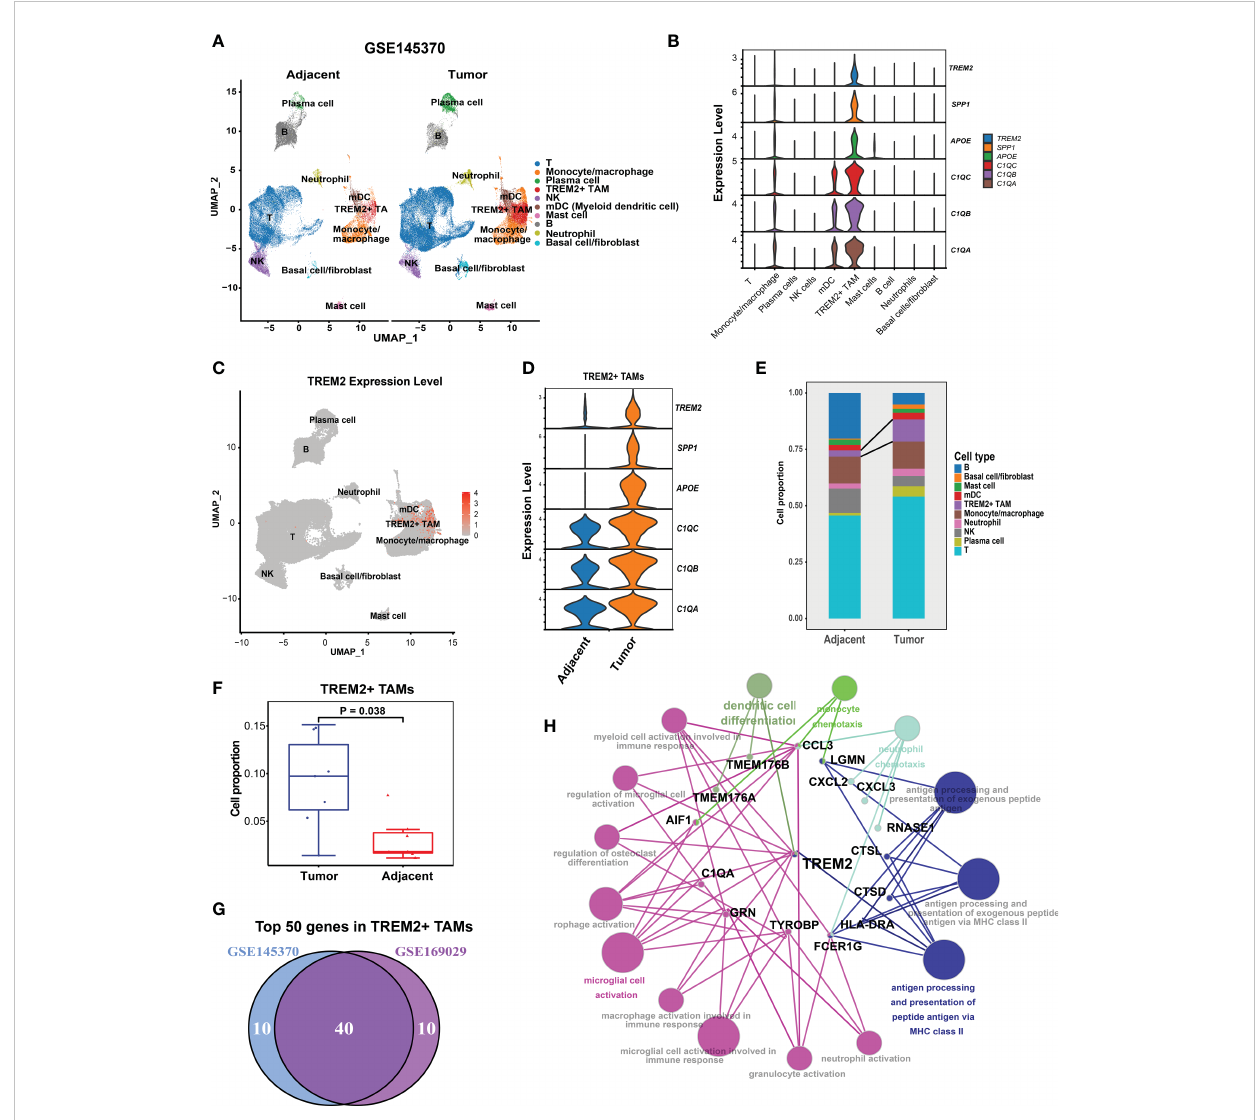
FIGURE 2 Validation of presence of TREM2 + TAMs by GSE145370. (A) UMAP plot of cells colored by cell types and splitted by tumor and adjacent normal tissue. (B) Violin plot showing expression level of APOE, SPP1, TREM2, C1QA, C1QC , and C1QB among 10 cell types. (C) UMAP plot showing expression level of TREM2 in each cell type. (D) Violin plot showing expression level of of SPP1 , APOE , TREM2 , and three complement genes in TREM2 + TAMs between tumor and adjacent normal tissue. (E) Cell proportion of 10 cell types in tumor and adjacent normal tissue. (F) Cell proportion comparison of TREM2 + TAMs between two group, each dot represents a sample using Wilcoxon rank-sum test. (G) Venn plot showing 40 overlapping genes of top 50 highly expressed genes in TREM2 + macrophage between GSE145370 and GSE169029. (H) The functionally grouped network of immune system process gene ontology terms by ClueGO/CluePedia for the interpretation of TREM2+ TAM gene signature ’ s biological roles. Small red dots represent genes and colour nodes represent immune system process gene ontology terms. Node colours represent distinct functional groups. Node size represents the signi fi cance of the terms. The more signi fi cant the terms are, the larger highlighted